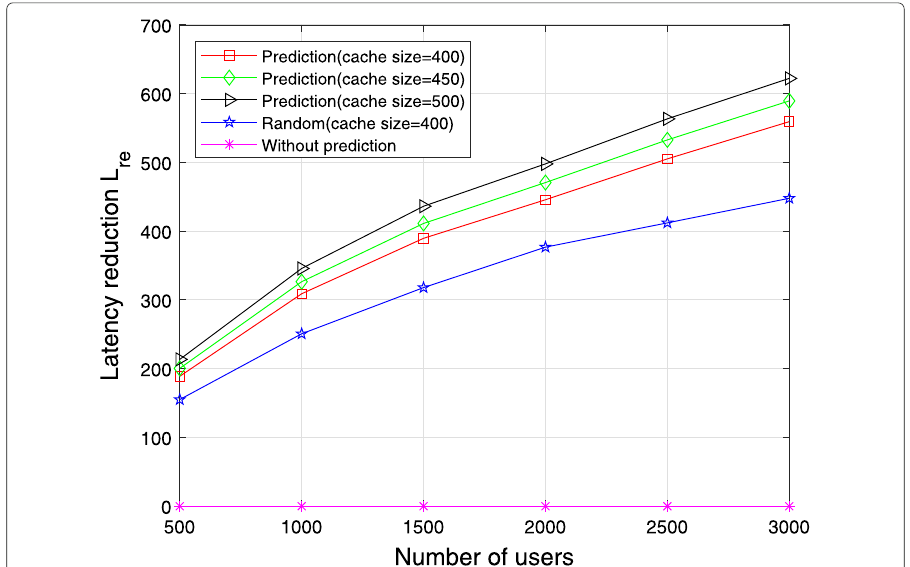
Fig. 9 Latency reduction versus the number of